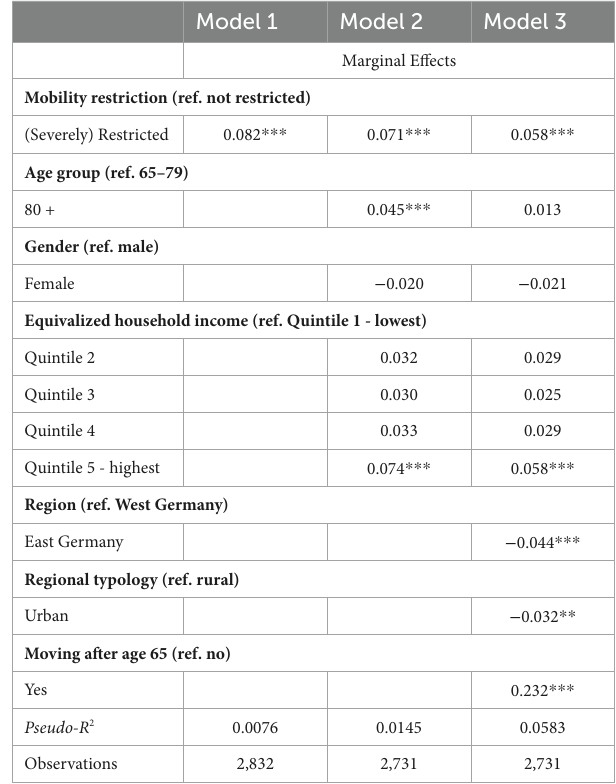
TABLE 2 Determinants of living in a barrier-reduced residence among those 65 or